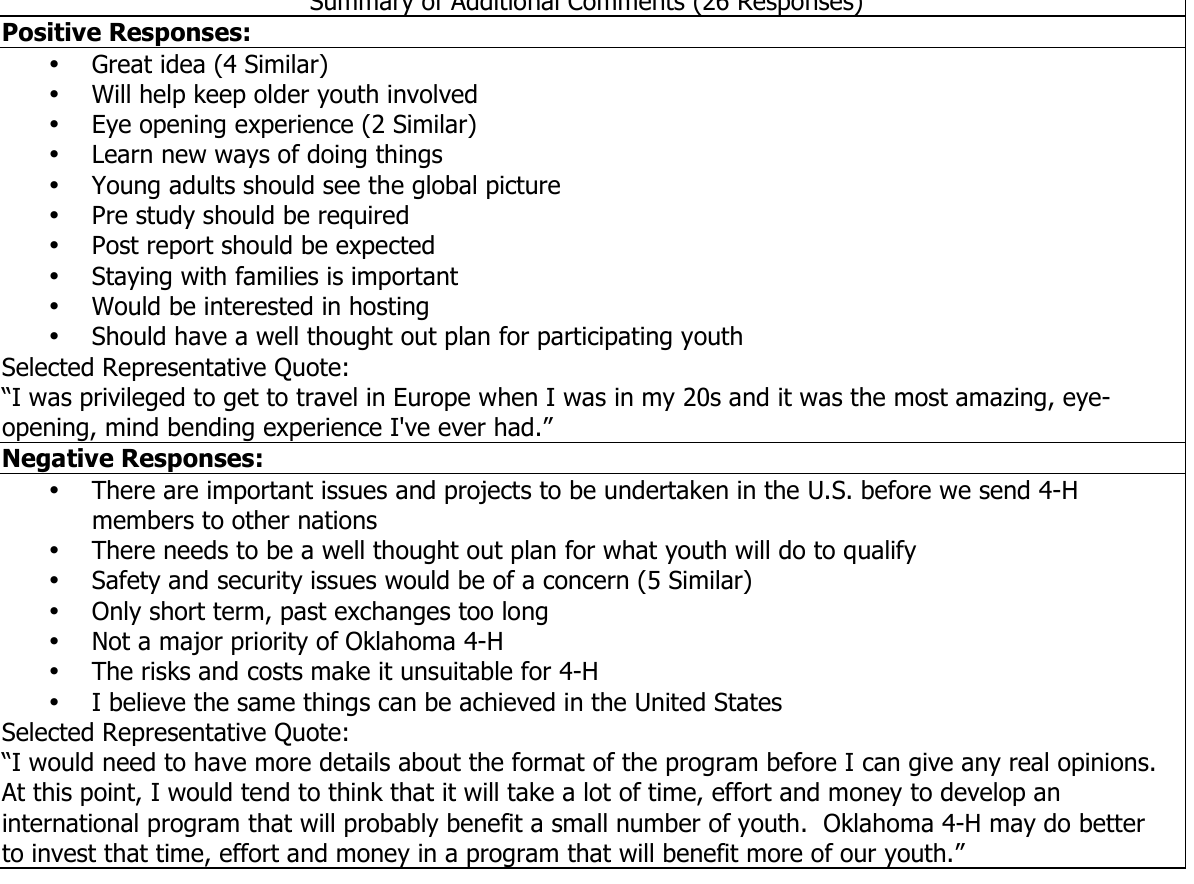
Positive and negative responses of respondents’ additional comments with representative